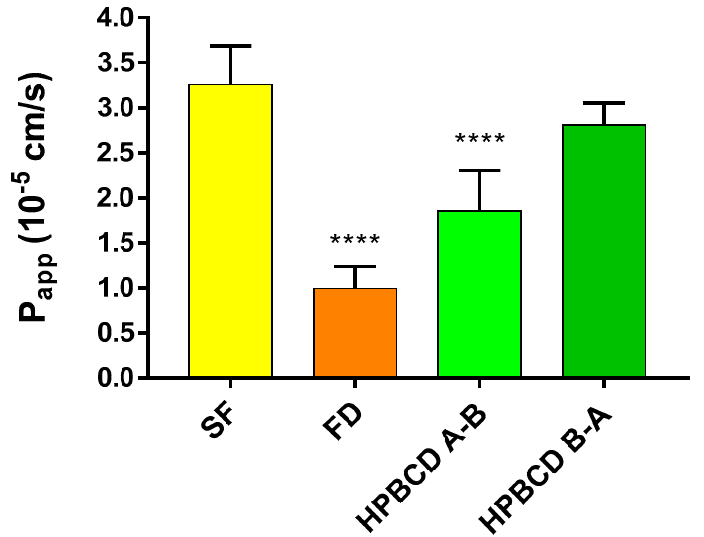
Figure 8. Permeability of FITC-HPBCD (50 µ M) and marker molecules (SF, FD) on hCMEC/D3 cells. Values presented are means ± SEM. Statistical analysis: one-way analysis of variance followed by Tukey’s multiple comparisons post-test. **** p < 0.0001, compared to SF treated group, n for